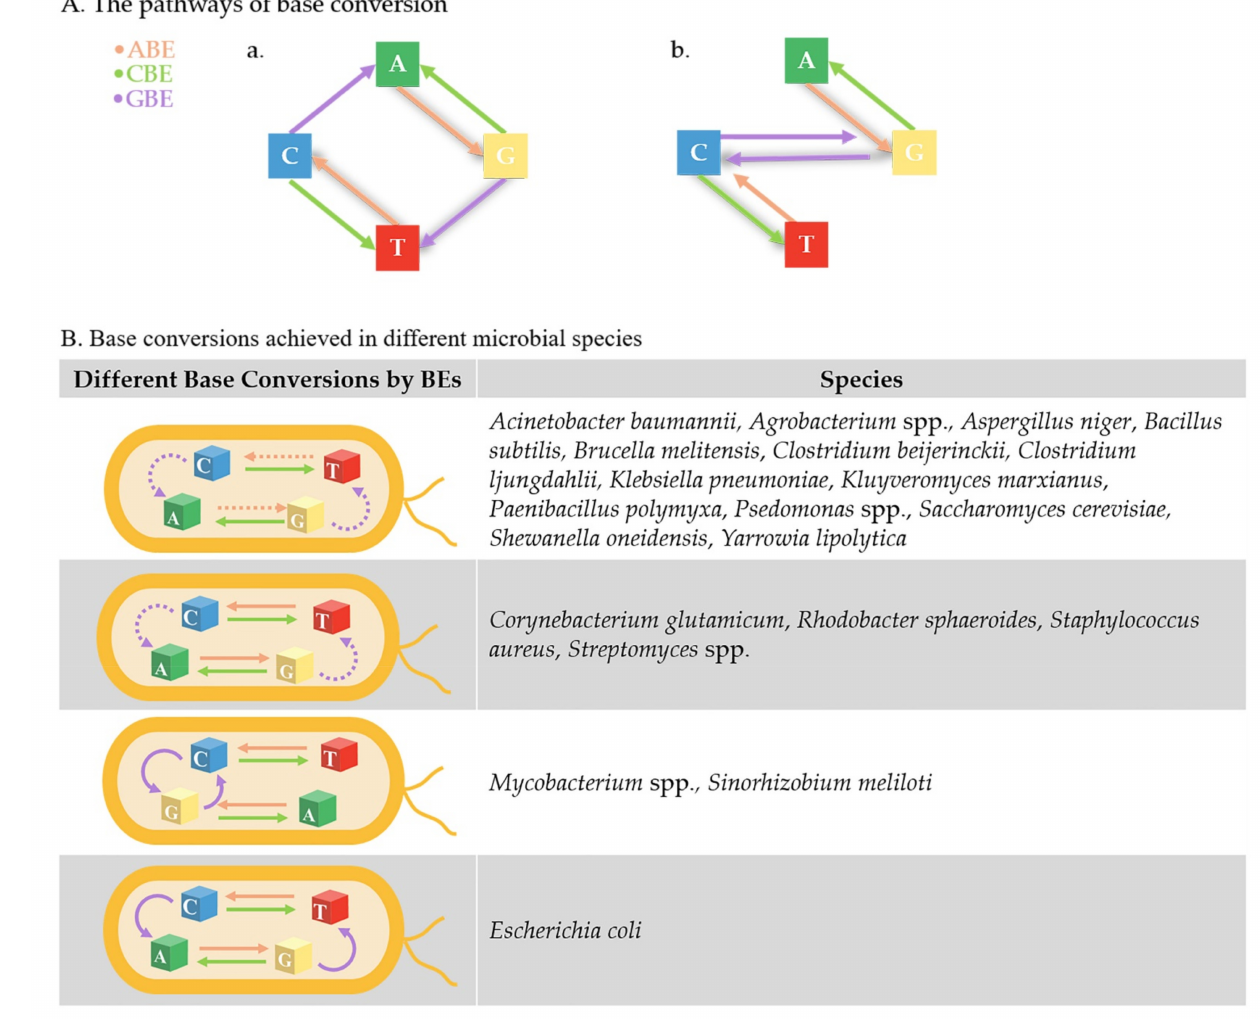
Figure 4. Current development of BEs in different microbial species. ( A ) In theory, any base pair could be converted to any of the others, which only takes three steps at most using the combination of ABE, CBE, and GBE. Firstly, C:G and T:A can be converted to each other by CBE and ABE. Secondly, C:G can be converted to G:C or A:T by GBE. ( a ) If C:G is predominantly converted to A:T by GBE, the most complicated editing step, shaded in grey, is from A:T to C:G, by firstly converting A:T to G:C by ABE, then to T:A by GBE, and finally to C:G by ABE. ( b ) If C:G is predominantly converted to G:C by GBE, the most complicated conversion, shaded in grey, is from A:T to T:A, firstly converting A:T to G:C by ABE, then to C:G by GBE, and finally converting to T:A by CBE. ( B ) The establishment of BEs in different microbes are listed in the table. The achieved base conversions are drawn with a solid line, and base conversions that have not been completed in some microbes are drawn with a dotted